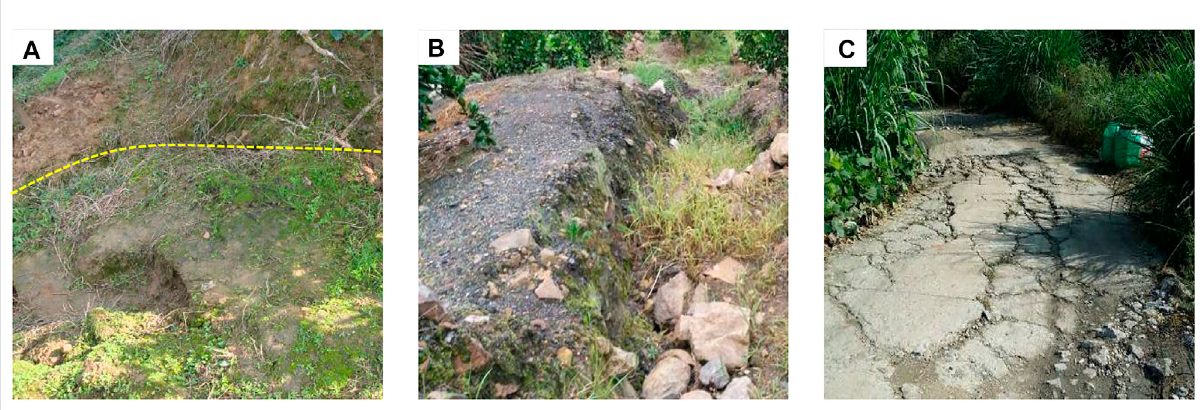
FIGURE 5 Thereare multiplecrackson bothsides ofthemiddle andrearofthelandslide (2016). (A) Boundary cracksappearon theeastsideofthemiddle andrearofthelandslide, (B) onthewestsideoftherearedgeofthelandslide,and (C) deformationanddamageoftheboundaryroadonthewestside of the landslide.